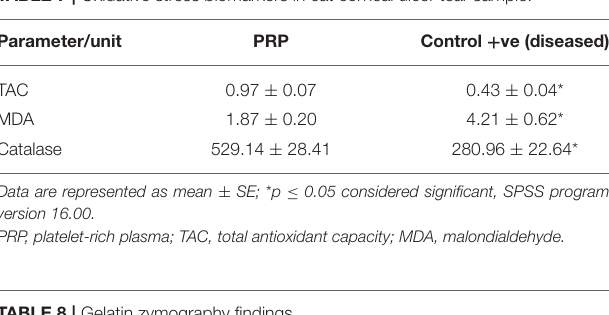
TABLE 7 | Oxidative stress biomarkers in cat corneal ulcer tear sample.